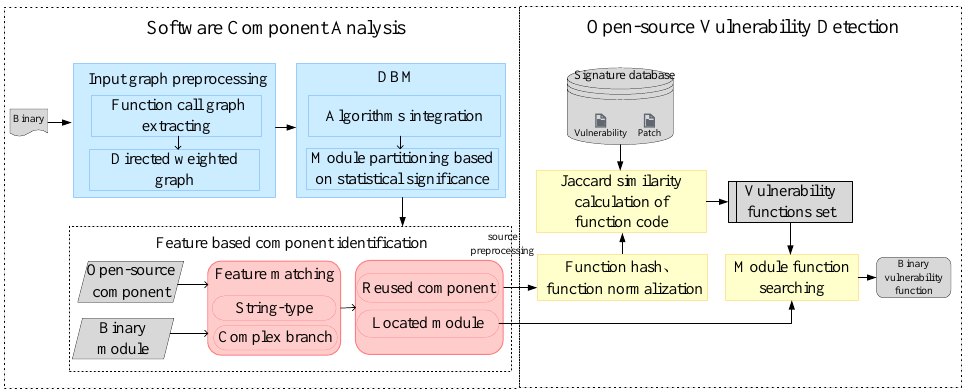
Figure 1. Workflow of